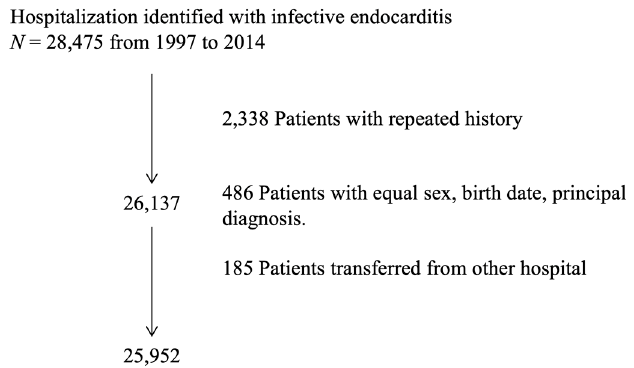
Figure 1. Flow chart of patient enrolment. Exclusion criteria.